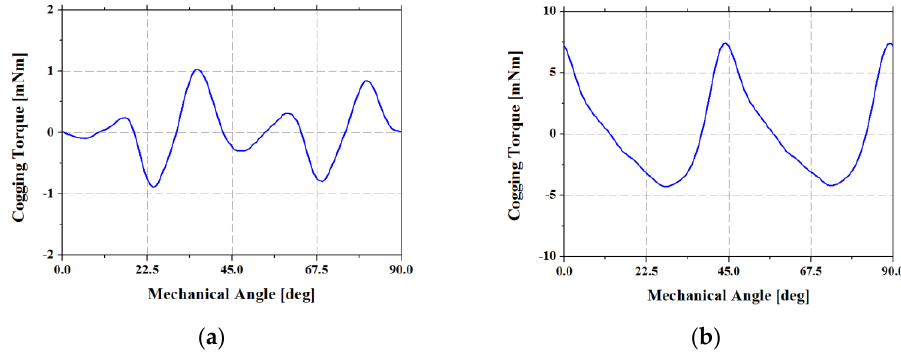
Figure 14. Comparison of cogging torque waveforms: ( a ) base model; ( b ) proposed model. The root mean square (RMS) and peak values of the back-EMF in the base model were 7.49 and 10.63 V, respectively. In the proposed model, the RMS value of the back-